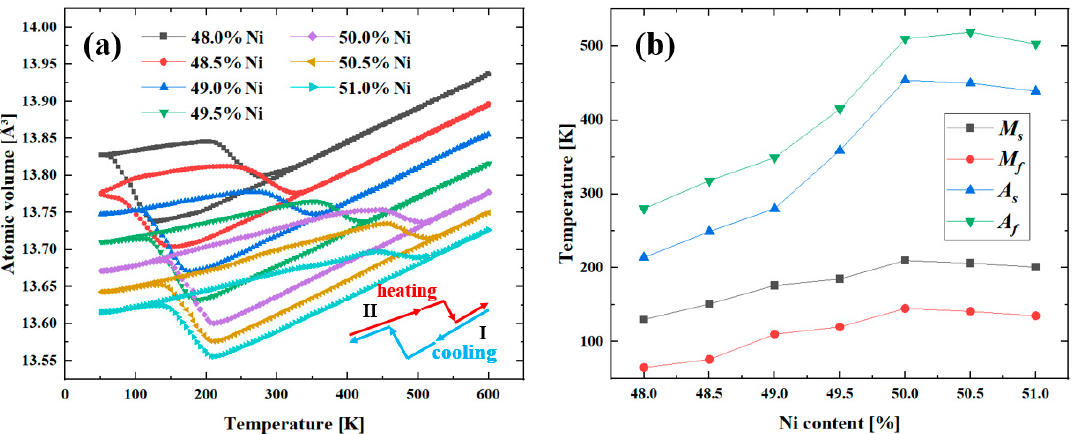
Figure 10. ( a ) The specimen volume for single crystalline NiTi alloys with different Ni content dur- ing cooling and heating processes. ( b ) Phase transformation temperature for single crystalline NiTi alloys with different Ni content.